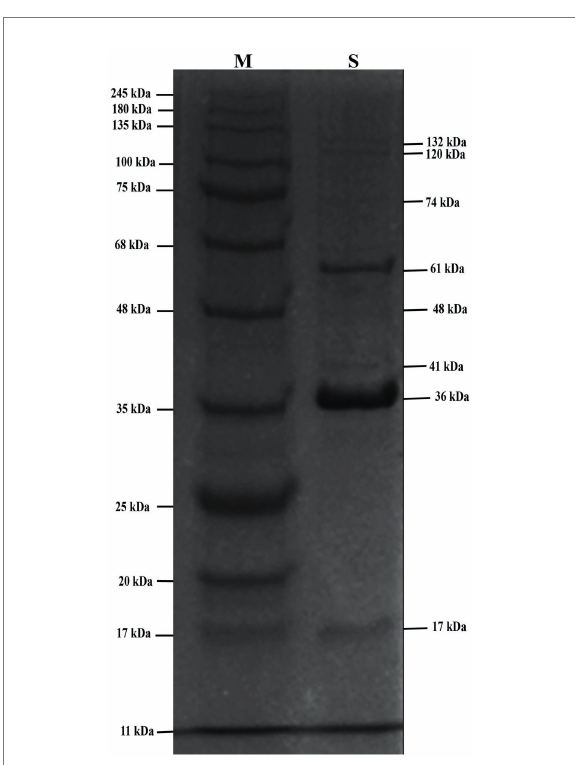
FIGURE 6 The SDS-PAGE analysis of phage STWB21 structural proteins on 12.5% gel staining with Coomassie brilliant blue. M, a standard marker of molecular weight